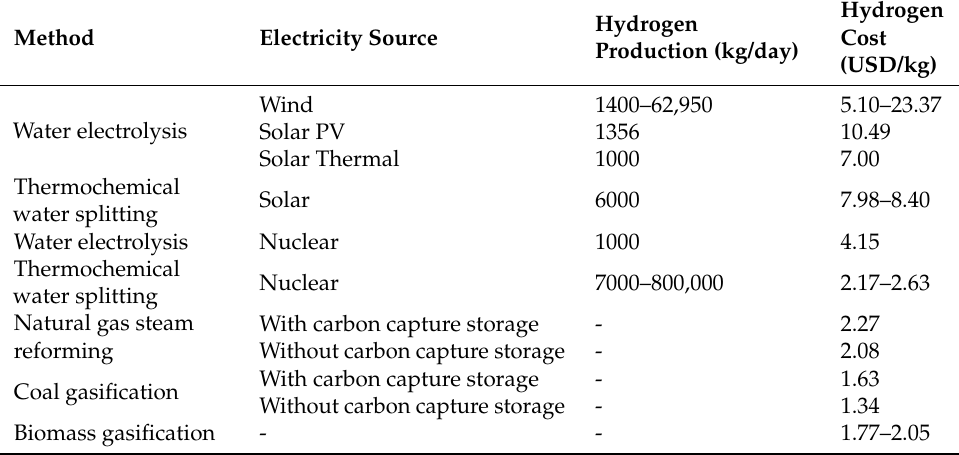
Table 7. Comparing the cost of hydrogen production methods based on power sources. Reprinted with permission